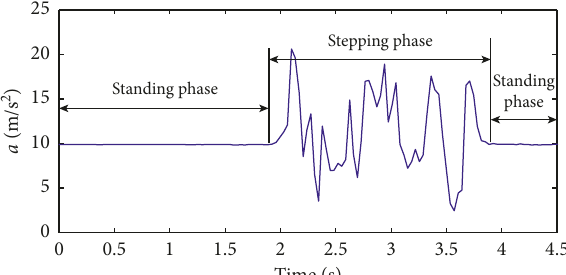
Figure 2: Acceleration change during the walking cycle.